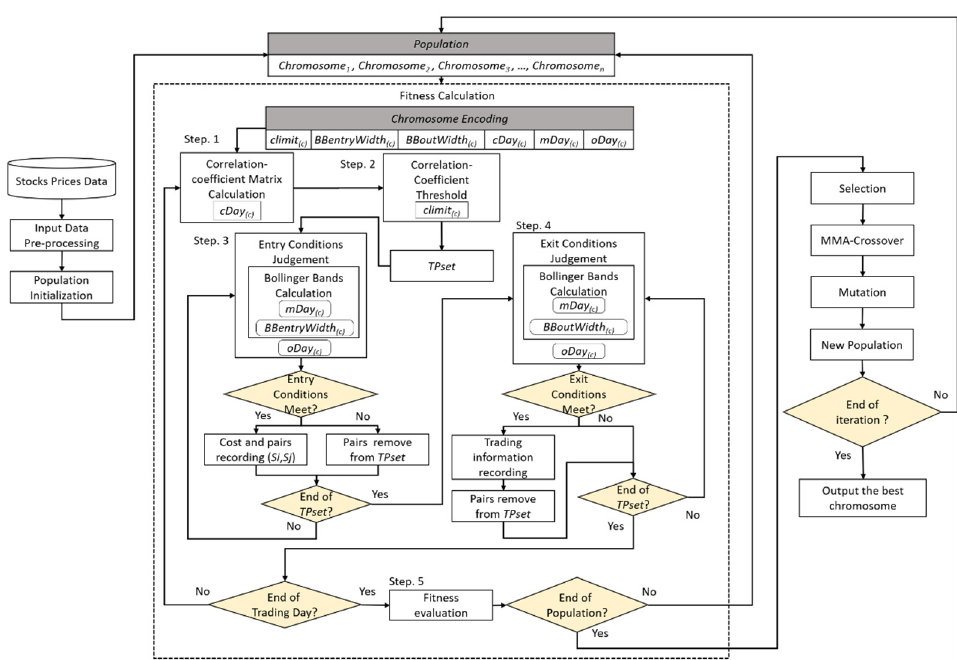
Figure 1. AGBCPT